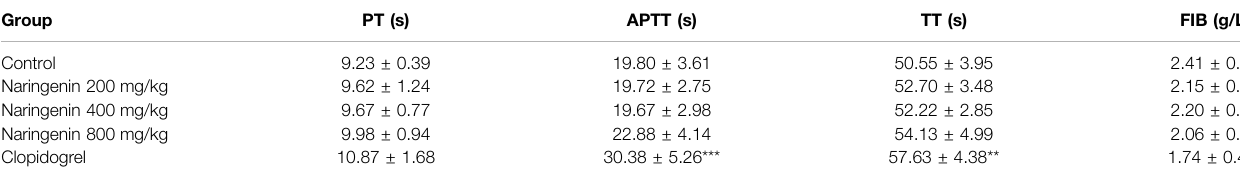
TABLE 2 | Effects of naringenin on PT, APTT, TT and FIB of rat plasma in vivo . Group PT